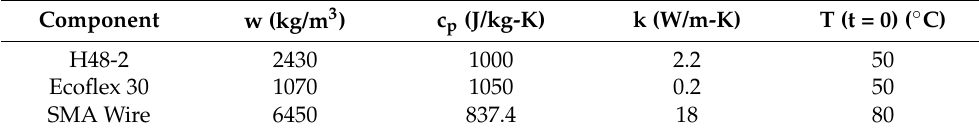
Table 1. Material properties and initial temperature conditions for studied geometry.